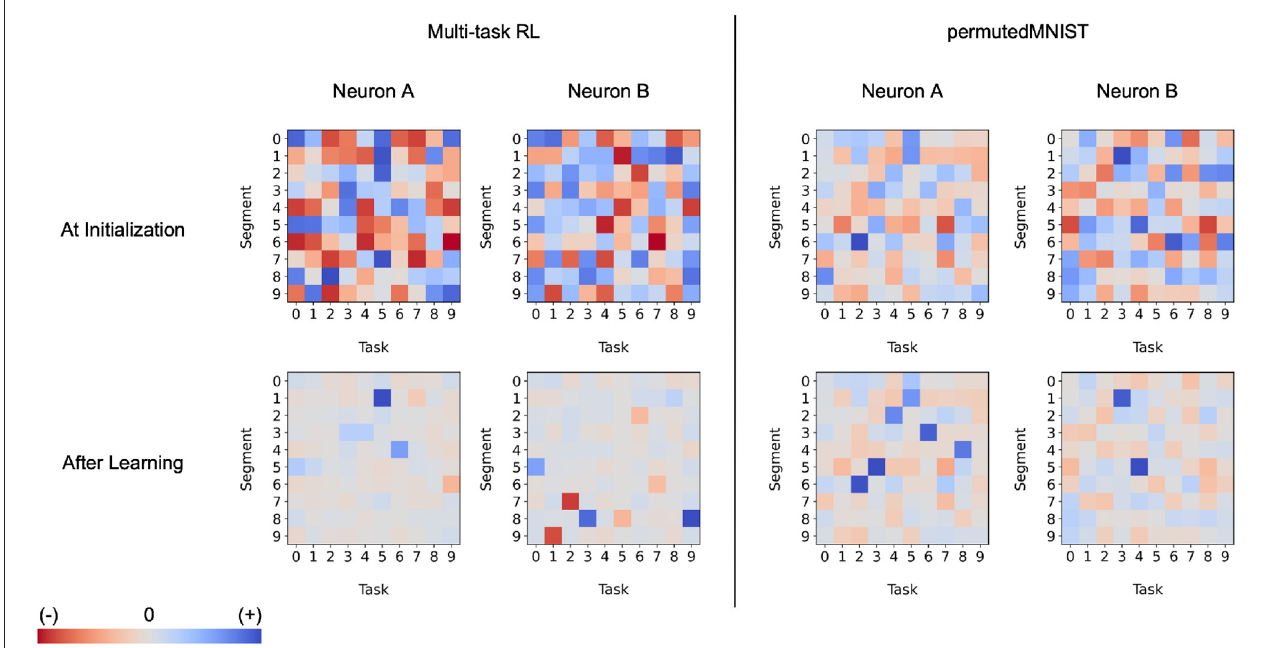
FIGURE 11 | The behavior of the dendritic segments of two separate neurons in a hidden layer of an Active Dendrites Network during three random evaluations of each MT10 task and 5,000 random evaluations of each permutedMNIST task. These charts show the activation computed by each dendritic segment given the context vector corresponding to each task, before (Top) and after (Bottom) training. Note that the dendritic segments for a particular neuron are completely separate of the segments of another in both multi-task RL and continual learning scenarios (e.g., Neuron A’s first segment is unrelated to Neuron B’s first